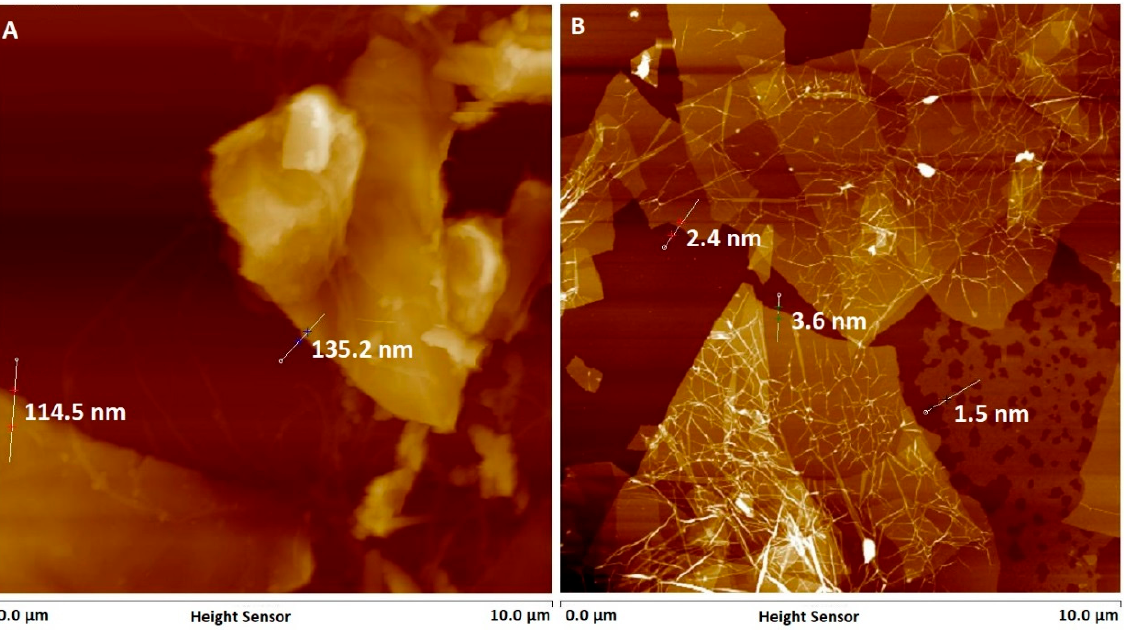
Figure 3. AFM topography images in air of GO_PAAM ( A ) and the native GO ( B ) with marked selected heights of the objects.